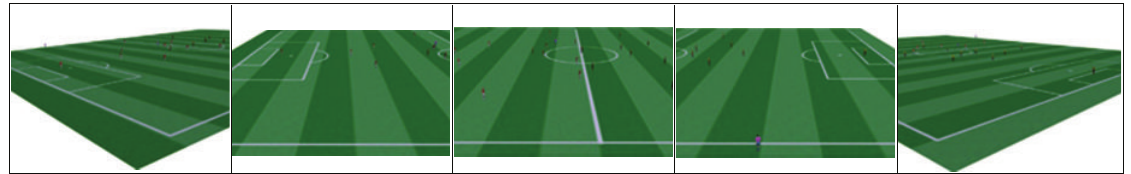
Figure 19: Workstations’ FOVs versus the illustration of them in server coverage aid